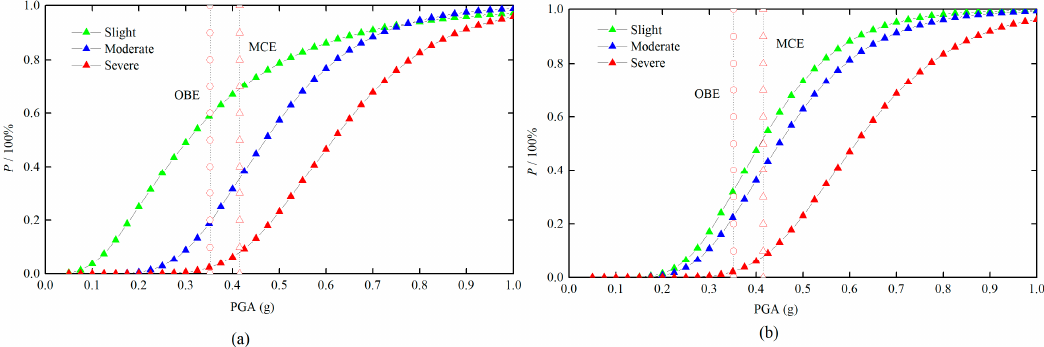
Figure 7. Seismic fragility curves for the Guandi dam. ( a ) Residual displacement-based; ( b ) damage- based.